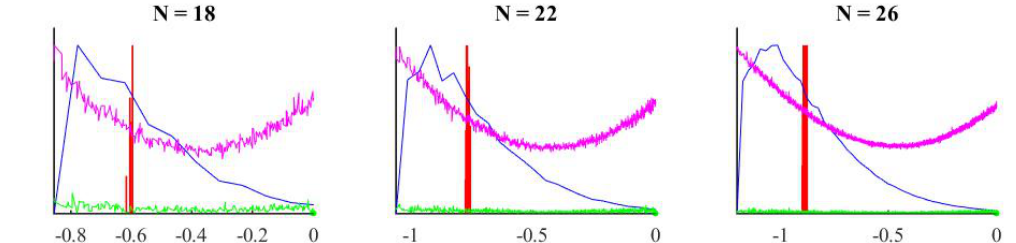
Figure 23 . The diagonal elements of (cid:0) [ S 1 ( t ) ; S 2 (0)] 2 at scrambling time (magenta) dominate over the superdiagonal (green) and is slowly varying in the energy region of the thermal ensemble (blue) and the equilibrium state (red).